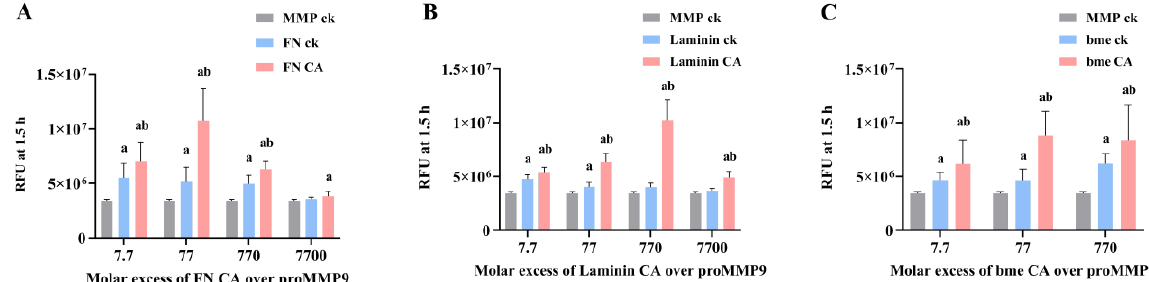
Figure 10. Effects of chloramines present on purified fibronectin, laminin-111 and mixture of ECM proteins present in the murine basement membrane extract (bme) on proMMP9 activation detected by fluorescence assay. Chloramines were generated by adding a 50-fold molar excess of HOCl to: ( A ) human plasma fibronectin (FN), ( B ) murine laminin-111 and ( C ) murine bme. Chloramine formation and concentrations were determined using the TNB assay, as outlined in Section 2. The preformed chloramines (at the indicated molar excesses over the proMMP9 concentration; pink bars labeled CA), or comparable concentrations of the parent proteins (blue bars, labeled ck), were then incubated with proMMP9 (13 nM) for 24 h at 37 °C, before the determination of the extent of the cleavage of the added profluorescent substrate by fluorescence detection. Controls with no added protein or chloramines (gray bars, labeled MMP ck) were also examined. Data are presented as means of the RFUs ± SDs of three technical replicates from each of the three biological replicates. Statistical analysis was performed using one-way ANOVA with Tukey’s multiple comparisons test. Statistical significance compared with the MMP control is indicated by a, and b indicates statistical differences compared with the native protein controls.